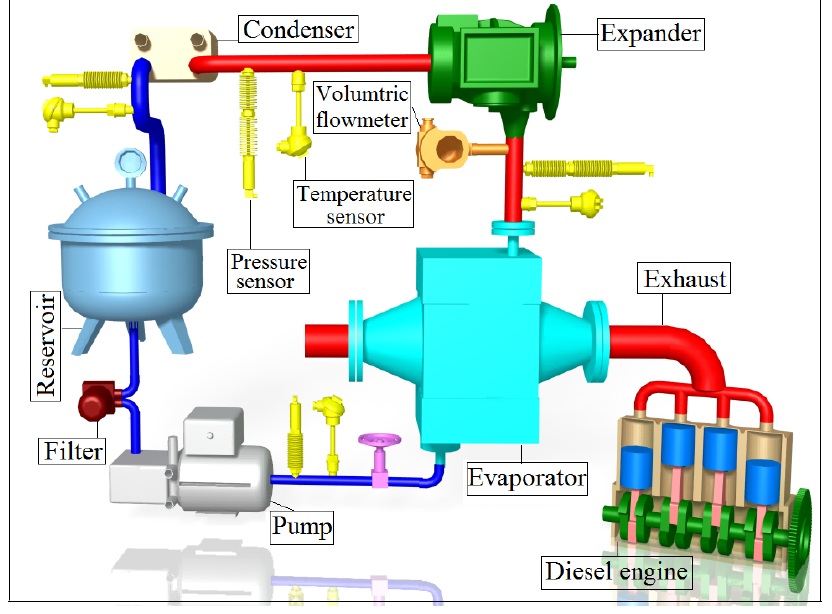
Figure 8. Schematic diagram of the vehicle diesel engine-ORC combined system.